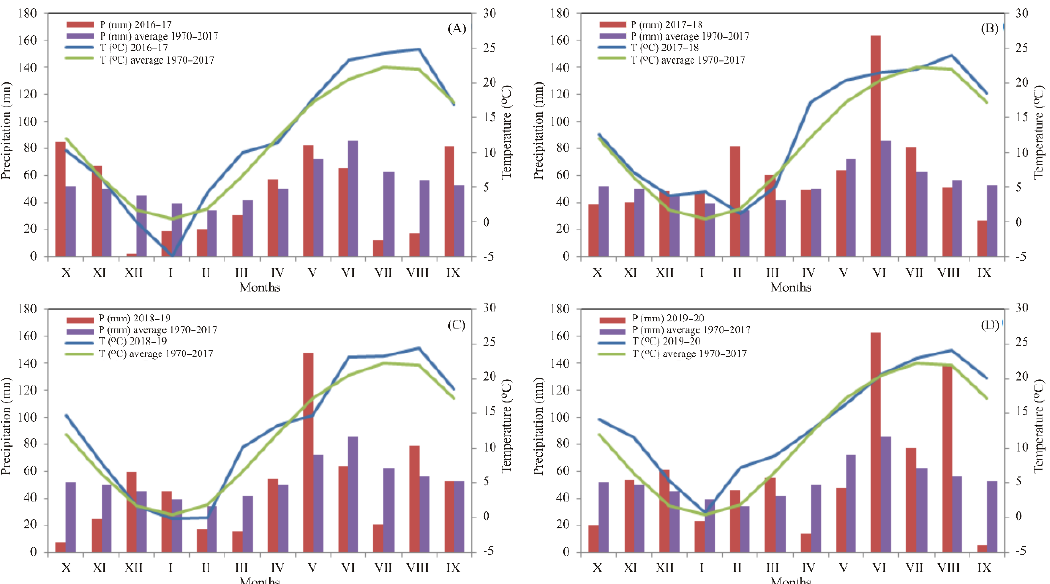
Figure 2. Long-term average (LTA) and total monthly precipitation (P) and average monthly air temperature (T) for hydrological years ( A ) 2016 − 2017, ( B ) 2017 − 2018, ( C ) 2018 − 2019, and ( D ) 2019 − 2020. Bars and left y − axis represent precipitation, and right y − axis and lines represent temperature data.